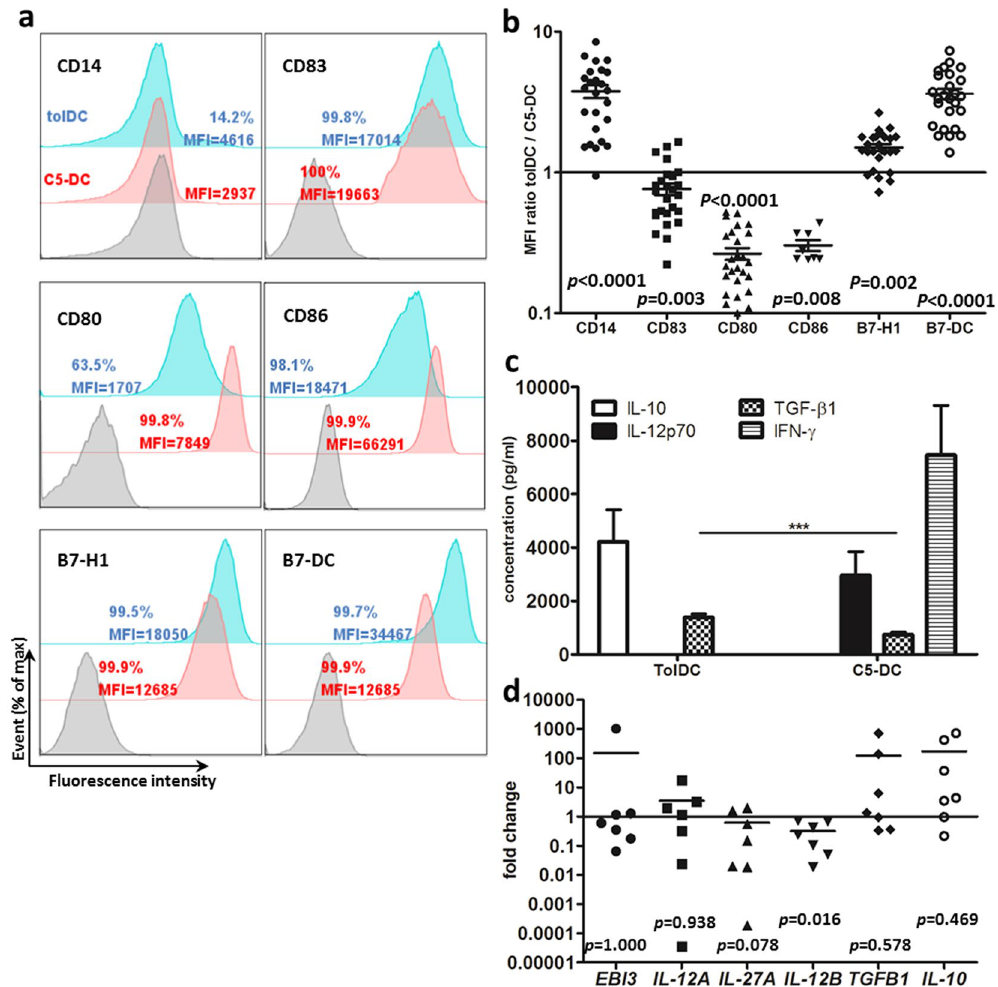
Figure 1. DC generation from monocytes with anti-inflammatory cytokines exhibited tolerogenic phenotype and produced anti-inflammatory cytokines. TolDC and C5-DC were harvested after maturation and characterized by flow cytometry, anti-CD14, anti-CD83, anti-CD80, anti-CD86 anti-B7-H1 and anti-B7-DC antibodies were used. ( a ) Histogram, ( b ) dot chart of MFI ratio tolDC to C5-DC. Data represent 26 independent experiments from 9 donors (CD86: n = 8). Wilcoxon signed-rank test was used to determine p values. ( c ) IL-10, IL-12p70, TGF- β 1 and IFN- γ quantification in DC supernatants using BD CBA Flex Set and ELISA. These data represent 10–19 independent experiments from 9 donors. Culture medium plus maturation cocktail without cells were used as control. Turkey test was used to determine the statistical significance. *** p < 0.001. RNA was isolated from tolDC and C5-DC, and quantified by RT-PCR, ( d ) Relative RNA level of IL-35 and related genes, IL-10 , TGFB1 in tolDC, C5-DC as control. ACTB , G6PDH or CYPB mRNA were determined from the same sample and used as endogenous reference genes. These data represent 7 independent experiments from 6 donors. Wilcoxon signed-rank test was used to determine p values. Error bars: